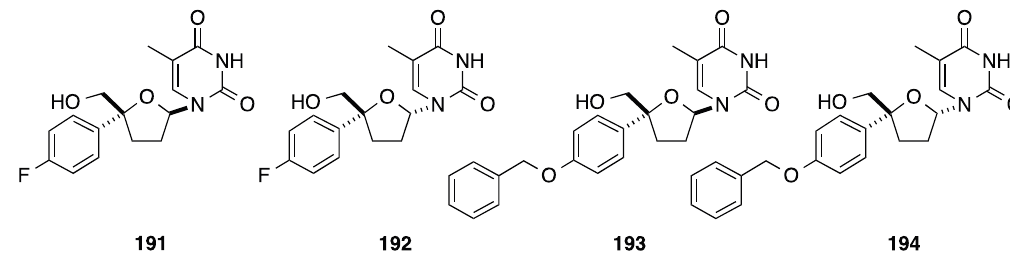
Figure 10. 4'- C -Phenyl thimidine analogues 191 – 194